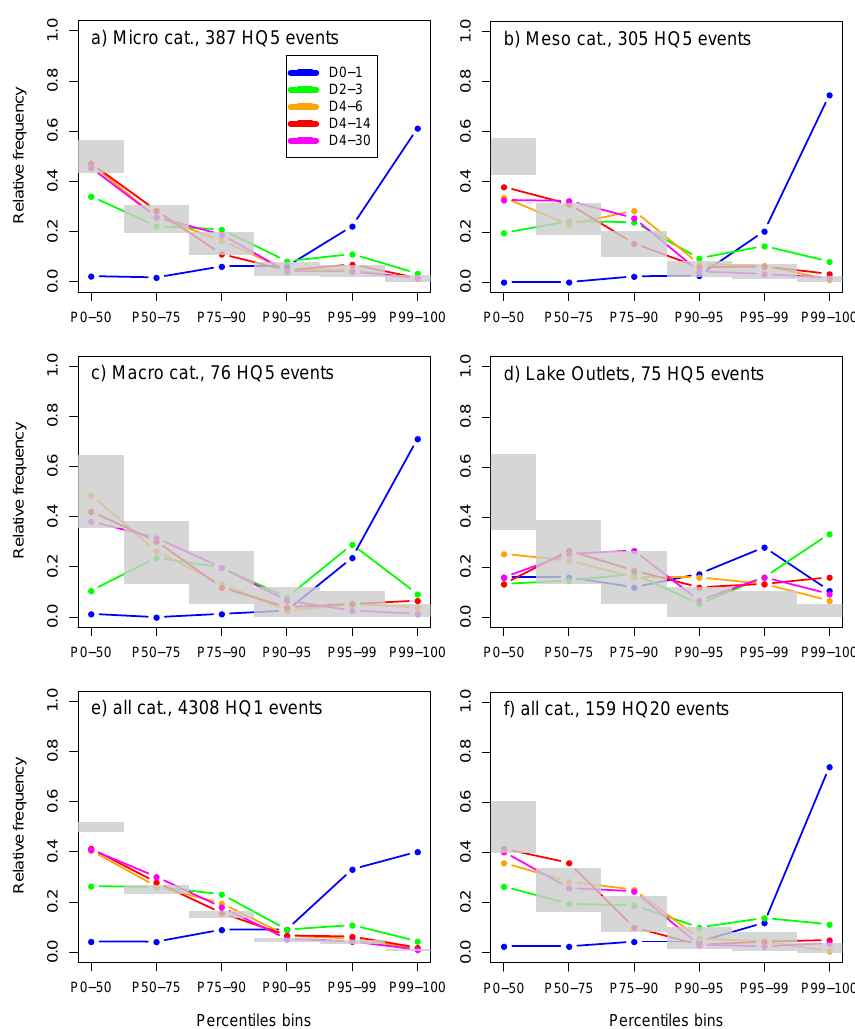
Figure 6. Relative frequency of precipitation percentiles for several PAPs before floods. Each colored line represents a PAP. (a) – (d) HQ5s in (a) Micro catchments, (b) Meso catchments, (c) Macro catchments and (d) Lake Outlets catchments. (e) All HQs and (f) HQ20s in all catchments. Gray shadings represent the 99% level of significance of the frequency of each percentile